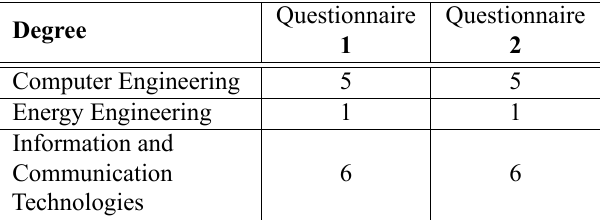
Table 1. Degree of the